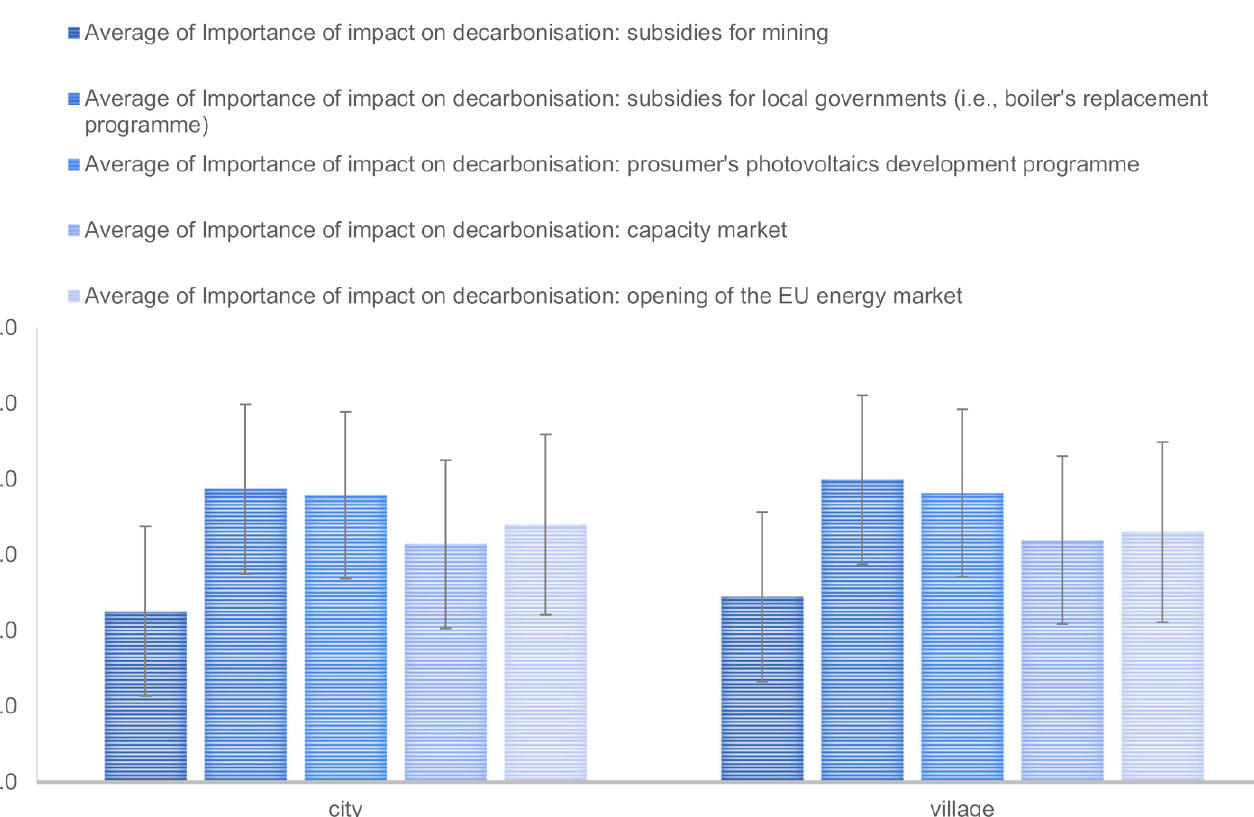
Figure 5. Average importance of impact on decarbonization with marked standard deviations. Source: Own research based on the results of an online survey, n = 444 (444 respondents who filled in the questionnaire online, of which 205 were men and 239 were women).